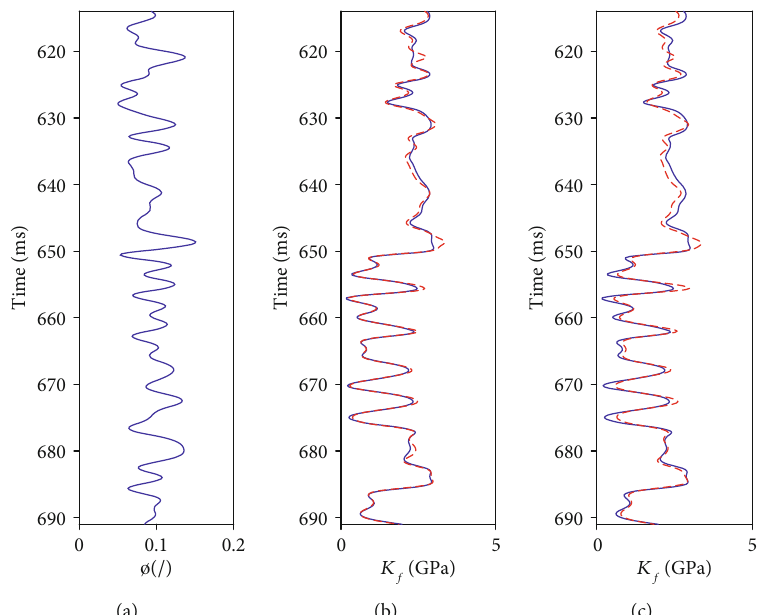
Figure 7: The comparison between the inverted fl uid modulus with our method and the method of Zong et al. [26] from the noise-free angle gather. The left subplot (a) displays the variation of porosity with time, the middle subplot (b) shows the inverted fl uid modulus with our method (red dashed line) and the true fl uid modulus (blue solid line), and the right subplot (c) shows the inverted fl uid modulus with the method of Zong et al. [26] (red dashed line) and the true fl uid modulus (blue solid